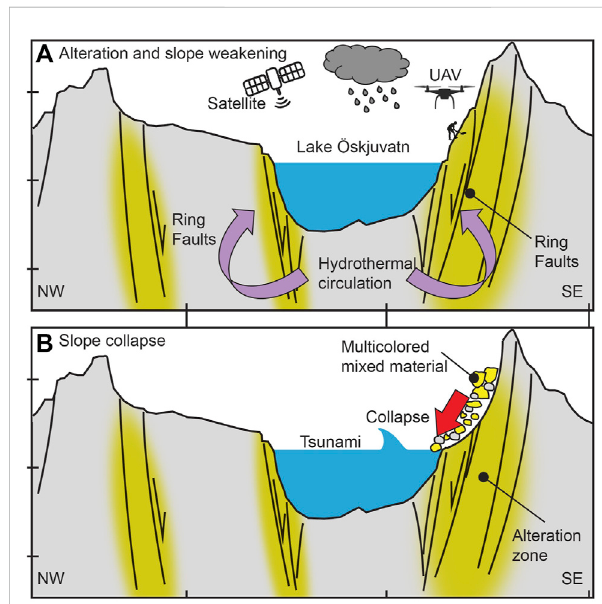
FIGURE 9 Conceptual model of collapsing mixed material. (A) Topographic pro fi leandfaultlines(shownasblacklines)attheAskjacalderasystem. Hydrothermalcirculation(yellowzones)includesmeteoricwatersand is inferred to be effective along the porous and permeable caldera rim that is dissected by abundant ring faults. Hydrothermal alteration of rocks is identi fi ed in satellite, drone and fi eld hyperspectraldata. (B) Collapseofthehydrothermallyactive fl ankinto the lake produces a tsunami, and deposits characterized by alteration andmulticoloredmaterials.Thecauseofthecollapsemaybelinkedto the alteration zone, involving a lower permeability that results in pore fl uid pressurization (after Heap et al., 2021). Instability of the SW fl ank and collapse into the lake was already described in Hartley and Thordarson (2012), pro fi le and fault lines after Trippanera et al.